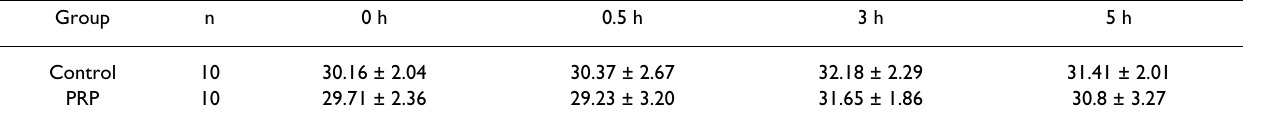
No significant difference between the temperature of control group and PRP